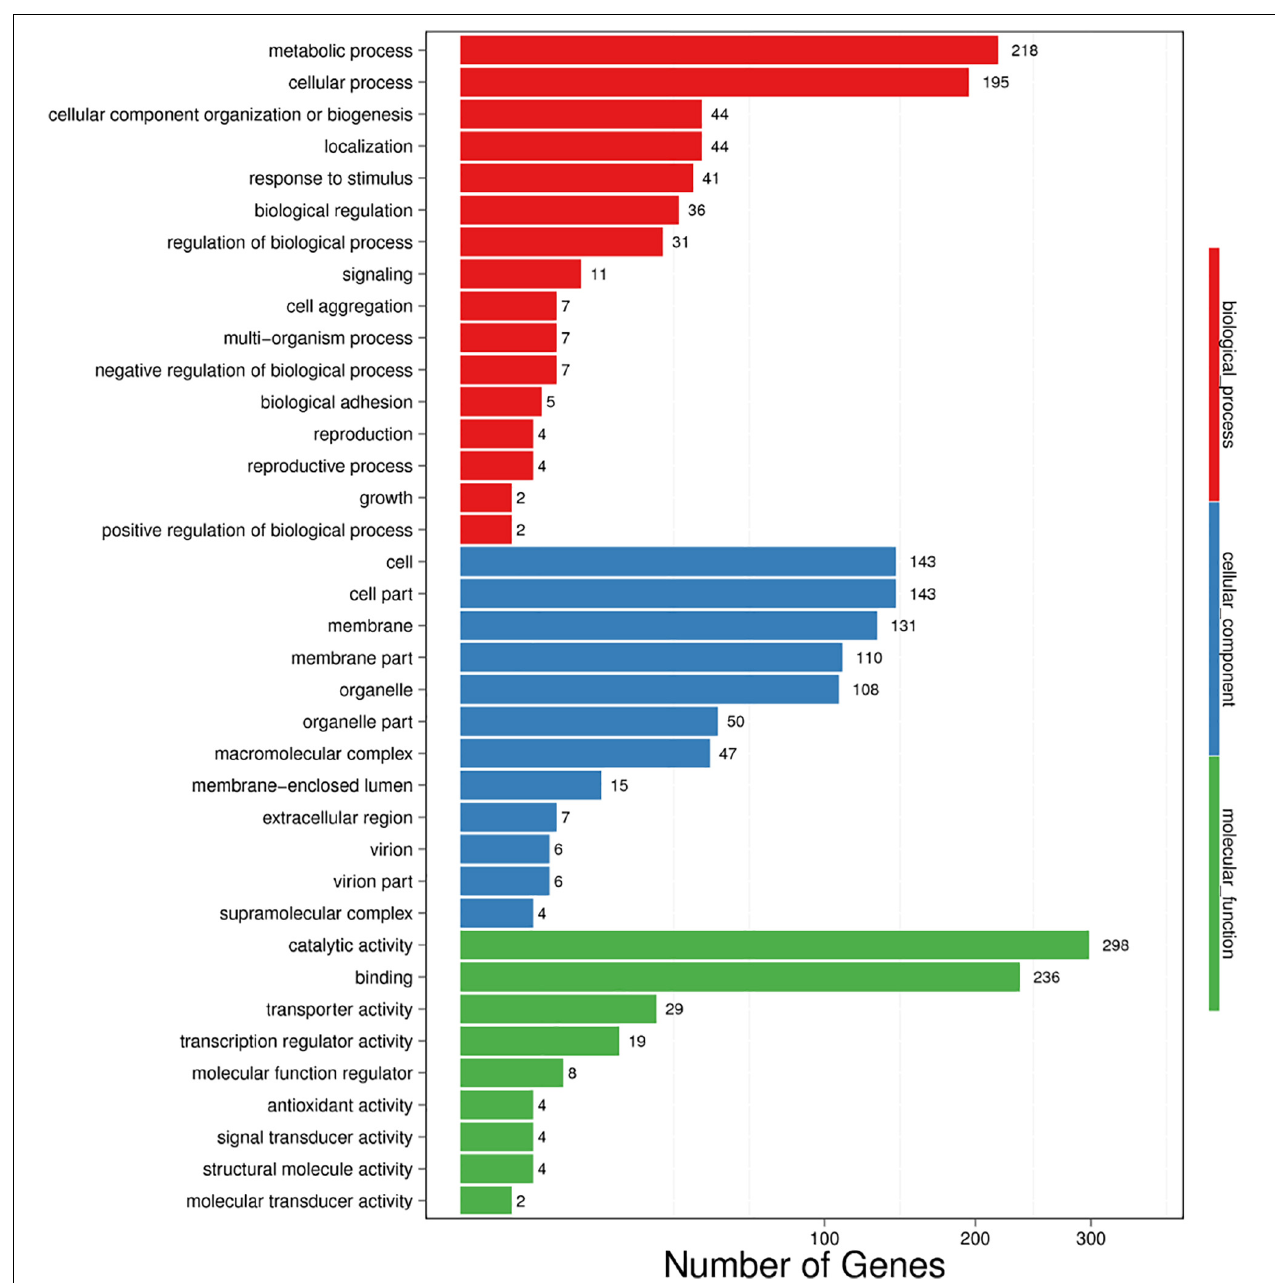
FIGURE 5 | Vertical histogram presentation of DEG-enriched GO terms. BP (red): biological process, CC (blue): cellular component, and MF (green): molecular